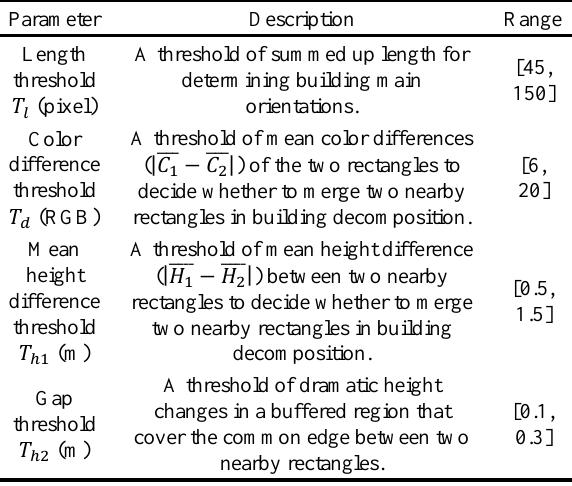
Table. 1. Building reconstruction